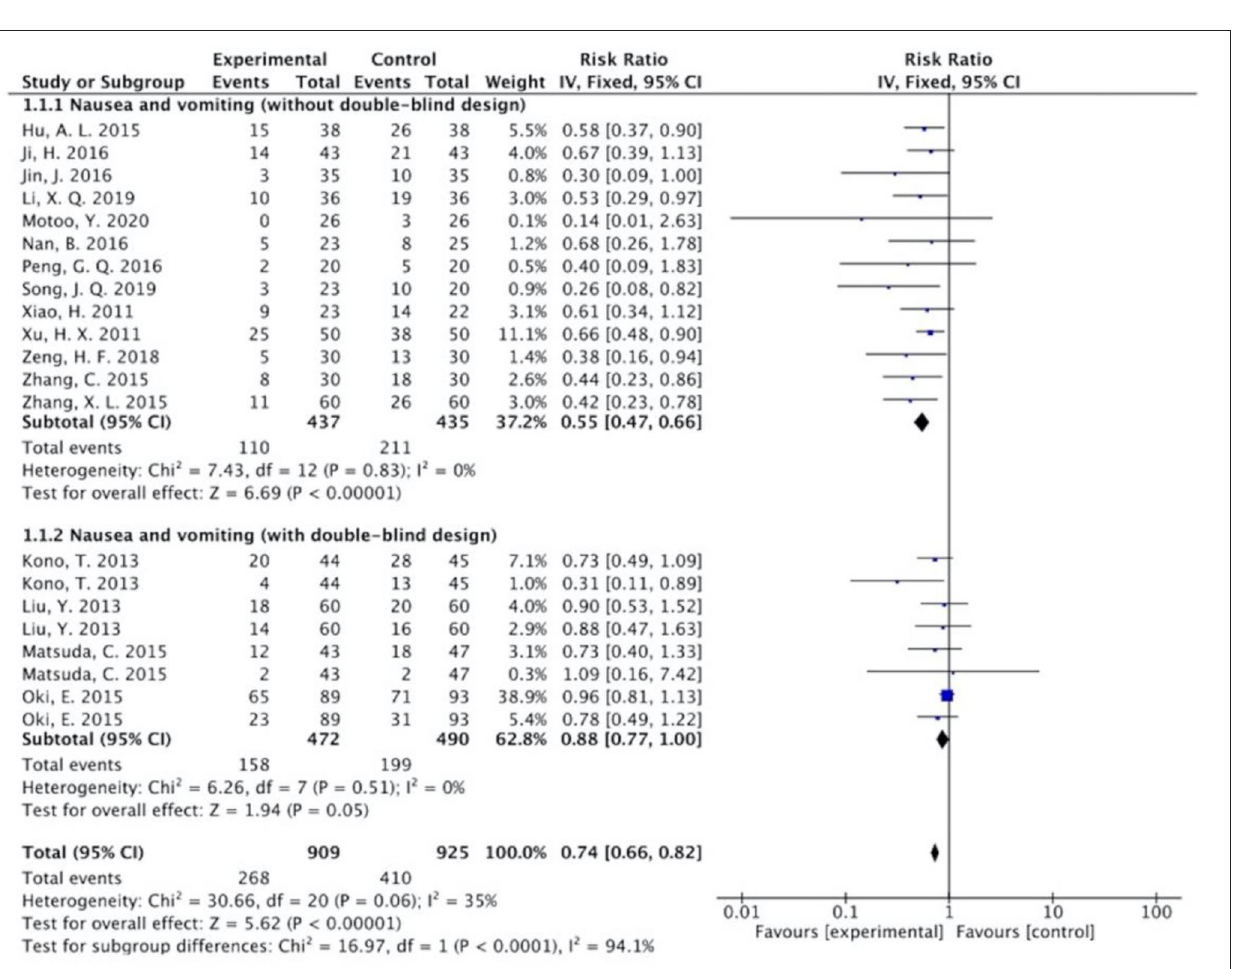
A. sinensis + G. uralensis + A. macrocephala + P. radix ; four combinations of five plants: A. sinensis + G. uralensis + A. macrocephala + C. reticulata + P. radix, G. uralensis + A. macrocephala + C. lacryma + A. membranaceus + C. pilosula, A. sinensis + G. uralensis + A. macrocephala + C.